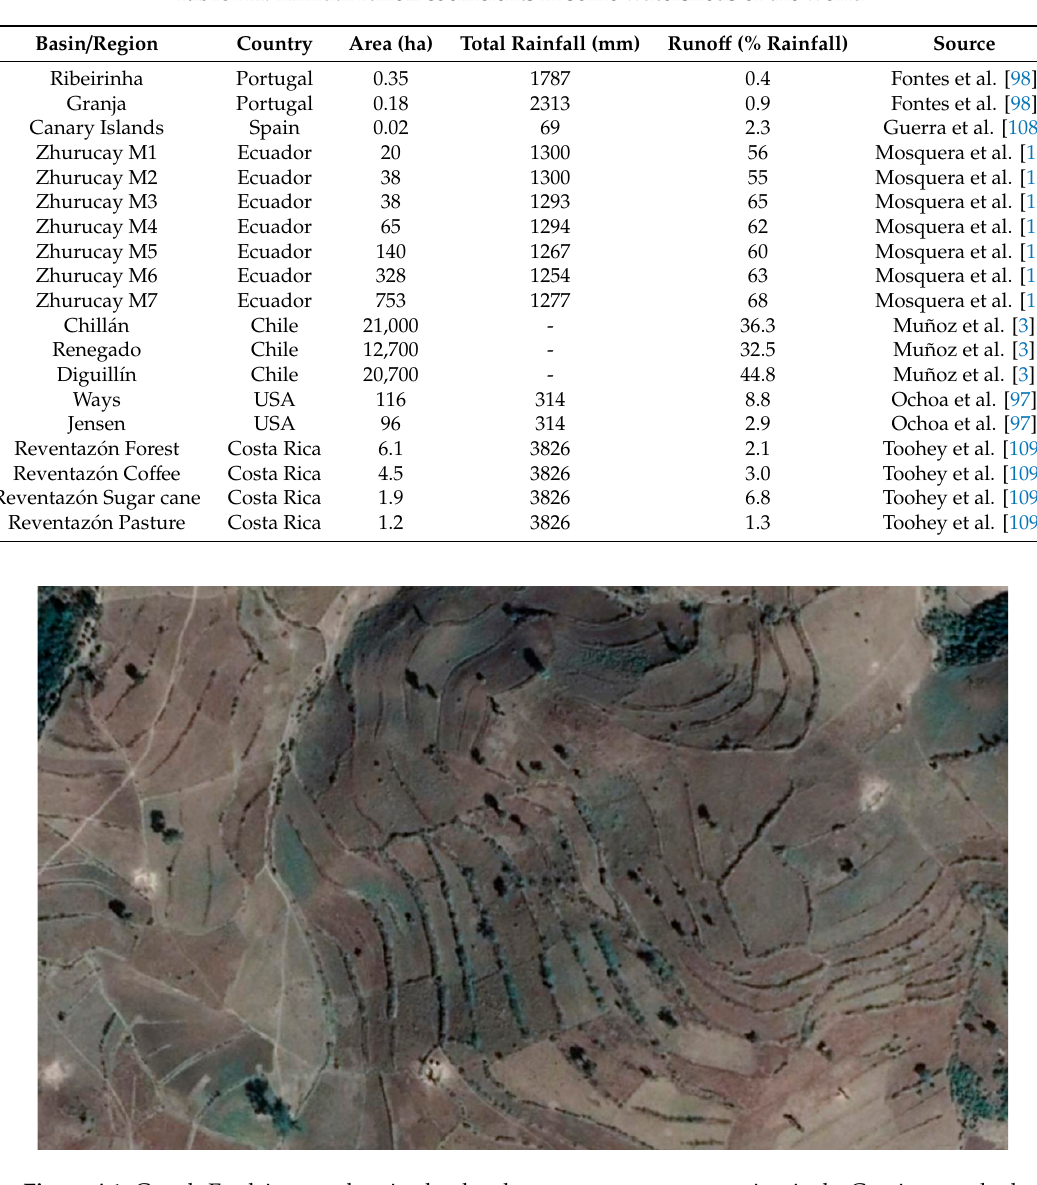
Figure A1. Google Earth images showing land and water management practices in the Gomit FigureA1. GoogleEarth imagesshowing landand watermanagementpractices inthe watershed.